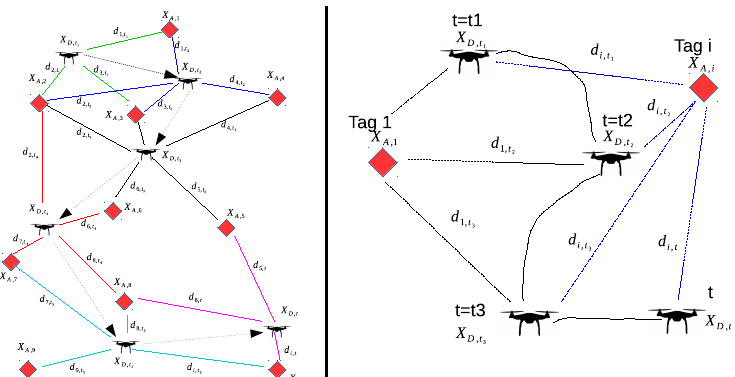
Figure 1. Multi-drone/anchor localization scenarios. ( Left ): A set of UWB tags with known positions are used to track a set of drones. ( Right ): A drone or a set of drones with estimated poses are used to retrieve unknown positions of a set of fixed UWB